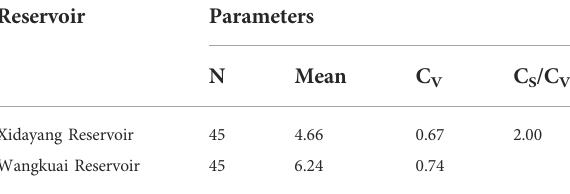
TABLE 3 The statistical parameters of the runoff frequency curves for theXidayangReservoirandthe WangkuaiReservoir(Unit:10 8 m 3 ).